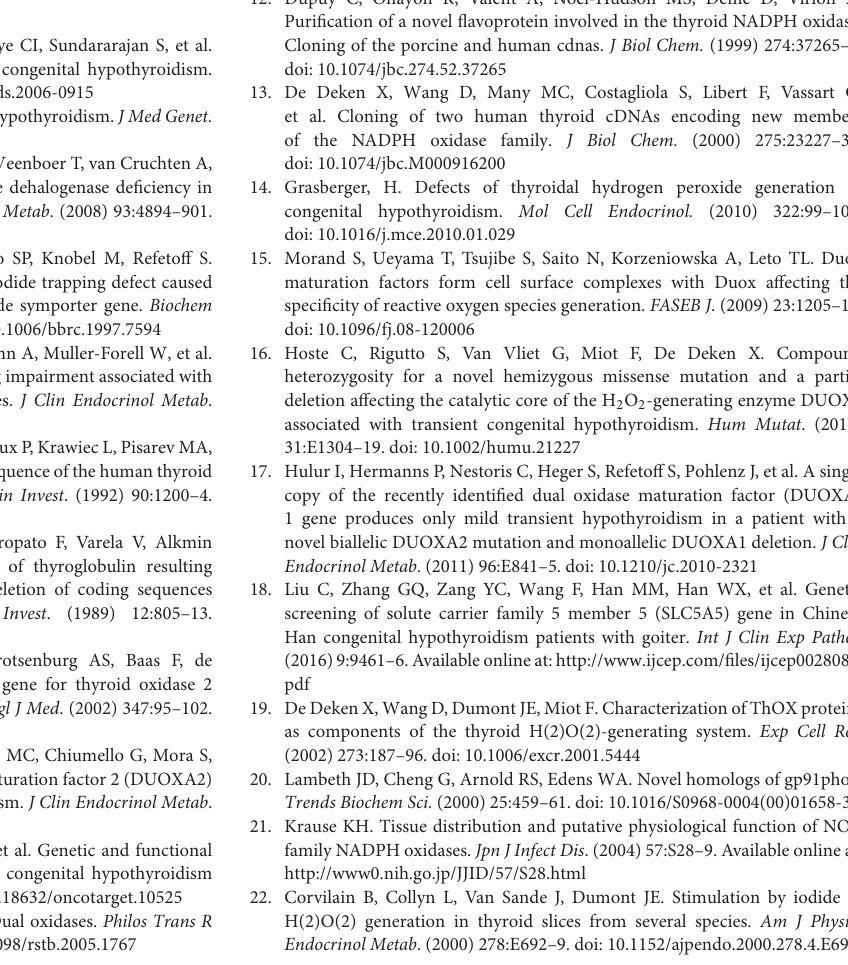
Supplementary Figure 1 | The standard calibration curve of H 2 O 2 release and fluorescence intensity. Supplementary Figure 2 | The size of the bands of DUOX1 protein in western